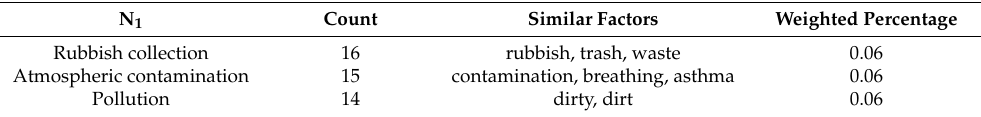
Table 9. Results for N 2 for environment factors identification.